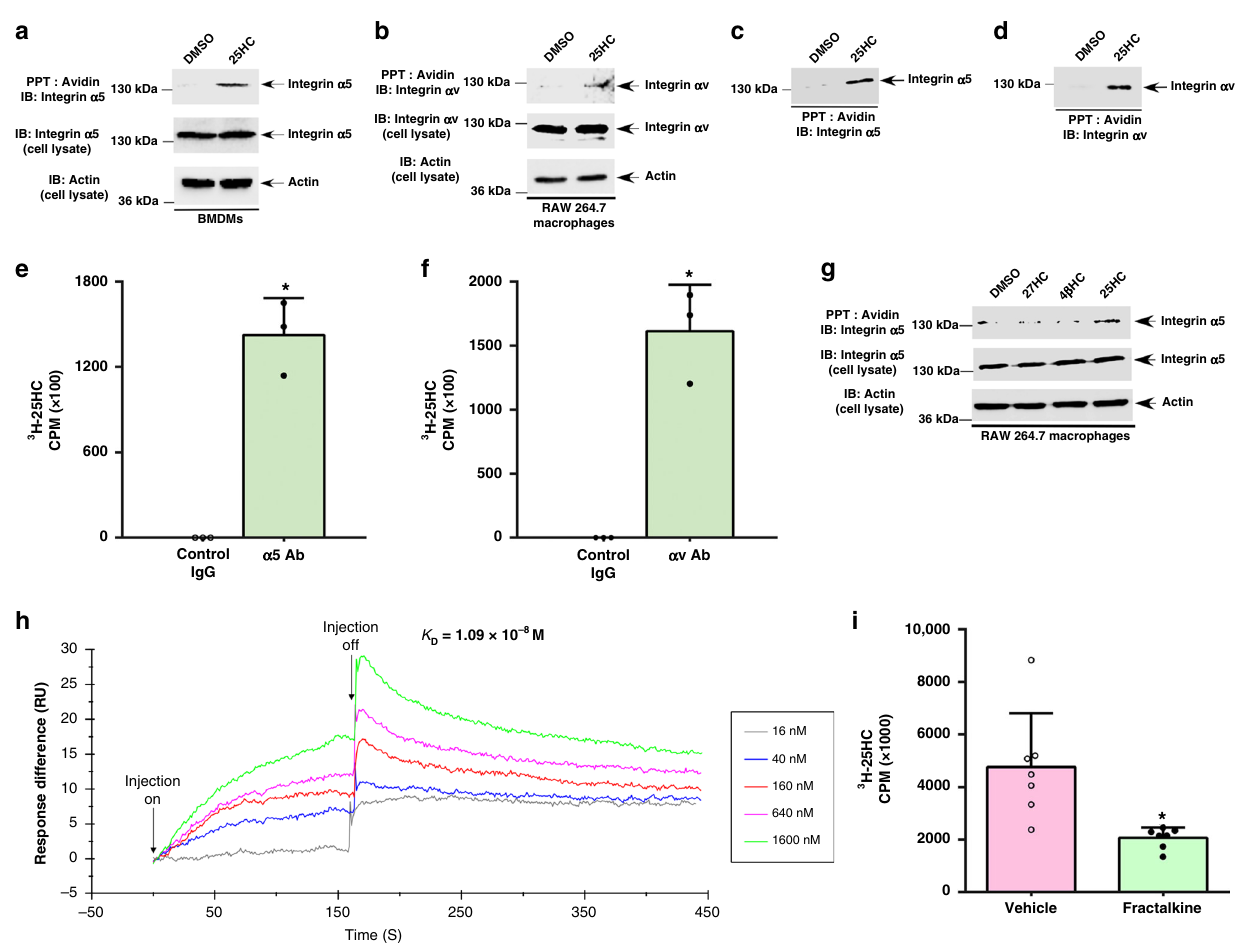
Fig. 2 25HC interacts with α 5 β 1 and α v β 3 integrins. a , b Biotinylation reactions were performed in the presence of either 25HC or DMSO (control). Cell lysates collected from BMDMs ( a ) or RAW 264.7 macrophages ( b ) incubated with biotinylated 25HC (biotin-25HC) or DMSO at 4 °C were precipitated (PPT) with avidin – agarose and subsequently immuno-blotted (IB) with either α 5 integrin ( a ) or α v integrin ( b ) antibody. Total lysates were also blotted with α 5 integrin ( a ), α v integrin ( b ), and actin ( a , b ) antibodies. c , d Biotin-25HC and DMSO (control) were incubated (PPT; precipitated) with avidin – agarose beads. 25HC conjugated beads were then incubated either with puri fi ed α 5 β 1 integrin ( c ) or α v β 3 integrin ( d ). The avidin – agarose bound complex was subsequently immuno-blotted with either α 5 integrin ( c ) or α v integrin ( d ) antibody. e , f Protein G-agarose beads were conjugated with either control IgG or antibody (Ab) speci fi c for α 5 integrin ( e ) and α v integrin ( f ). The beads were then incubated with either puri fi ed α 5 β 1 integrin ( e ) or α v β 3 integrin ( f ) protein. Control beads (control IgG + puri fi ed integrin protein) and integrin protein bound beads (integrin-speci fi c antibody + puri fi ed integrin protein) was incubated with tritiated 3 H-25HC. Bead-bound radioactivity (count per minute; CPM) was measured by scintillation counter. g Cell lysate collected from RAW 264.7 macrophages incubated with biotin-25HC, biotinylated 27-hydroxycholesterol (biotin-27HC), biotinylated 4 β - hydroxycholesterol (biotin-4 β HC) or DMSO (control) at 4 °C was precipitated (PPT) with avidin – agarose and subsequently immuno-blotted with α 5 integrin antibody. Total cell lysate was also blotted with α 5 integrin and β -actin antibodies. h Surface plasmon resonance (SPR) analyses were performed by injecting increasing concentrations of 25HC (16 nM, 40 nM, 160 nM, 640 nM, 1.6 µ M) into both the α v β 3 integrin-immobilized and control surface of the CM5 chips. Each background-corrected sensorgram is a representative of replicate runs. i Binding of radioactive 3 H-25HC to immobilized α v β 3 integrin protein in the presence or absence of puri fi ed chemokine domain of fractalkine protein was assessed as described in the “ methods ” section. Immunoblot images are representative from three independent experiments. The radioactive values (mean ± standard deviation) are representative from two independent experiments. * p ≤ 0.05 using a Student ’ s t -test protein-bound beads were then incubated with 3 H-25HC. We integrin, as α v β 3 integrin interacts with 25HC (Fig. 2b, d, f) and, detected binding of radioactive 25HC to both puri fi ed α 5 β 1 and more importantly, our molecular dynamics (MD) study (Fig. 3, α v β 3 integrins (Fig. 2e, f). The interaction of 25HC with below) suggested speci fi c binding of 25HC to site-II of α v β 3 integrin was speci fi c as our in vivo studies revealed that two integrin. First we performed SPR analyses by using a sensor chip closely related oxysterols, 27-hydroxycholesterol (27HC) and 4 β - in which α v β 3 integrin protein was immobilized. The speci fi city hydroxycholesterol (4 β HC), failed to interact with cell surface α 5 of 25HC – integrin interaction was borne out by the observation integrin subunits, in contrast to 25HC (Fig. 2g). that 25HC bound to α v β 3 integrin at a high-af fi nity (equilibrium We further con fi rmed the speci fi city of 25HC – integrin dissociation constant or K D of 1.09 × 10 − 8 M or 10.9 nM) (Fig. 2h). Interestingly, the K D value of 25HC-intigrin was interaction by two distinct methods, (a) surface plasmon comparable to the SPR-derived K D values reported for binding of resonance (SPR), and (b) competitive binding assay. In these integrin molecules with its matrix and growth factor ligands, two studies we analyzed the interaction of 25HC with α v β 3 NATURE COMMUNICATIONS| (2019) 10:1482